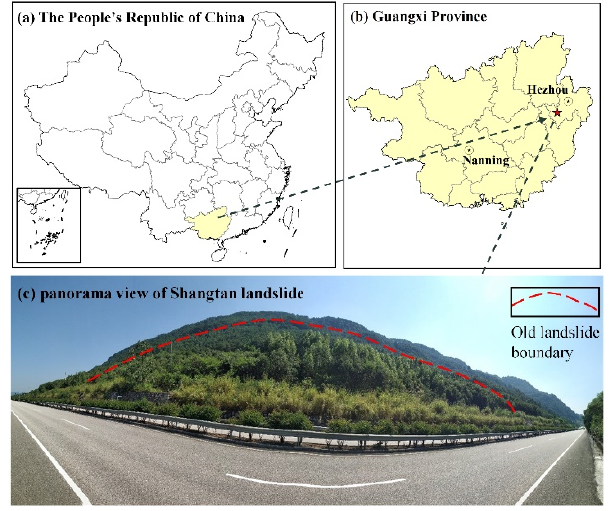
Figure 1. Location of the Shangtan landslide.